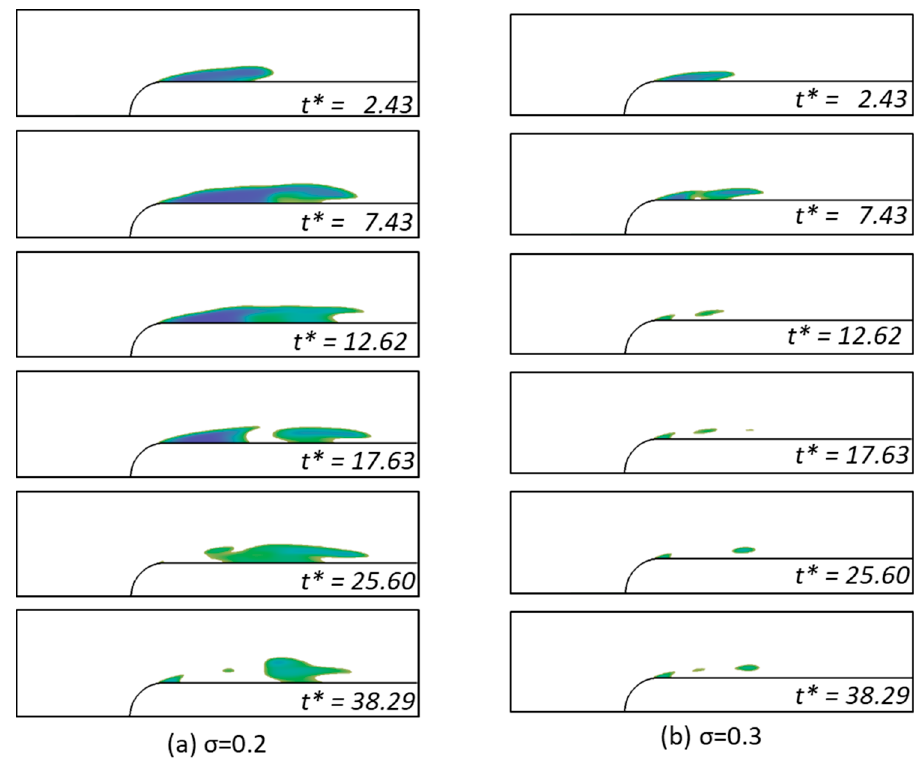
Figure 2. Surface pressure coefficient on the hemispherical head cylinder at various cavitation numbers.